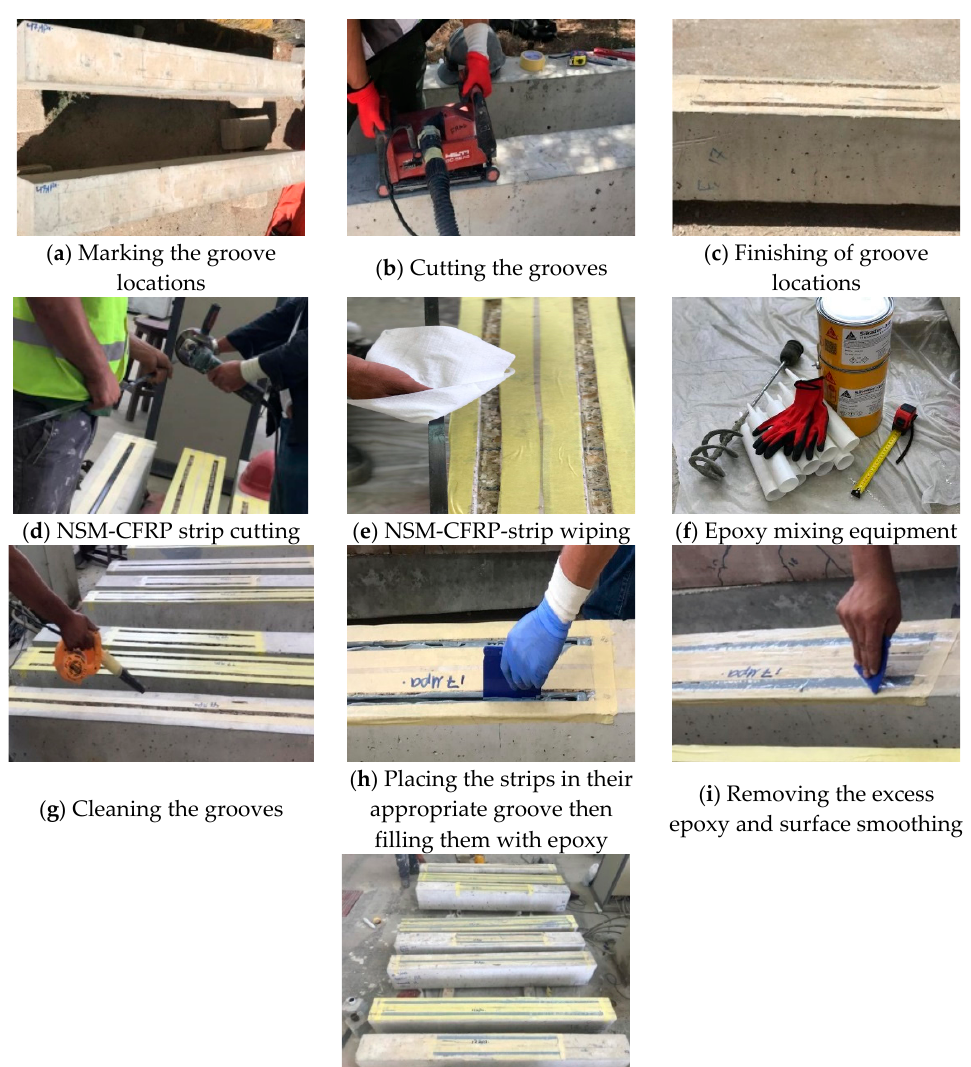
Figure 4. Installation of NSM-CFRP strips.